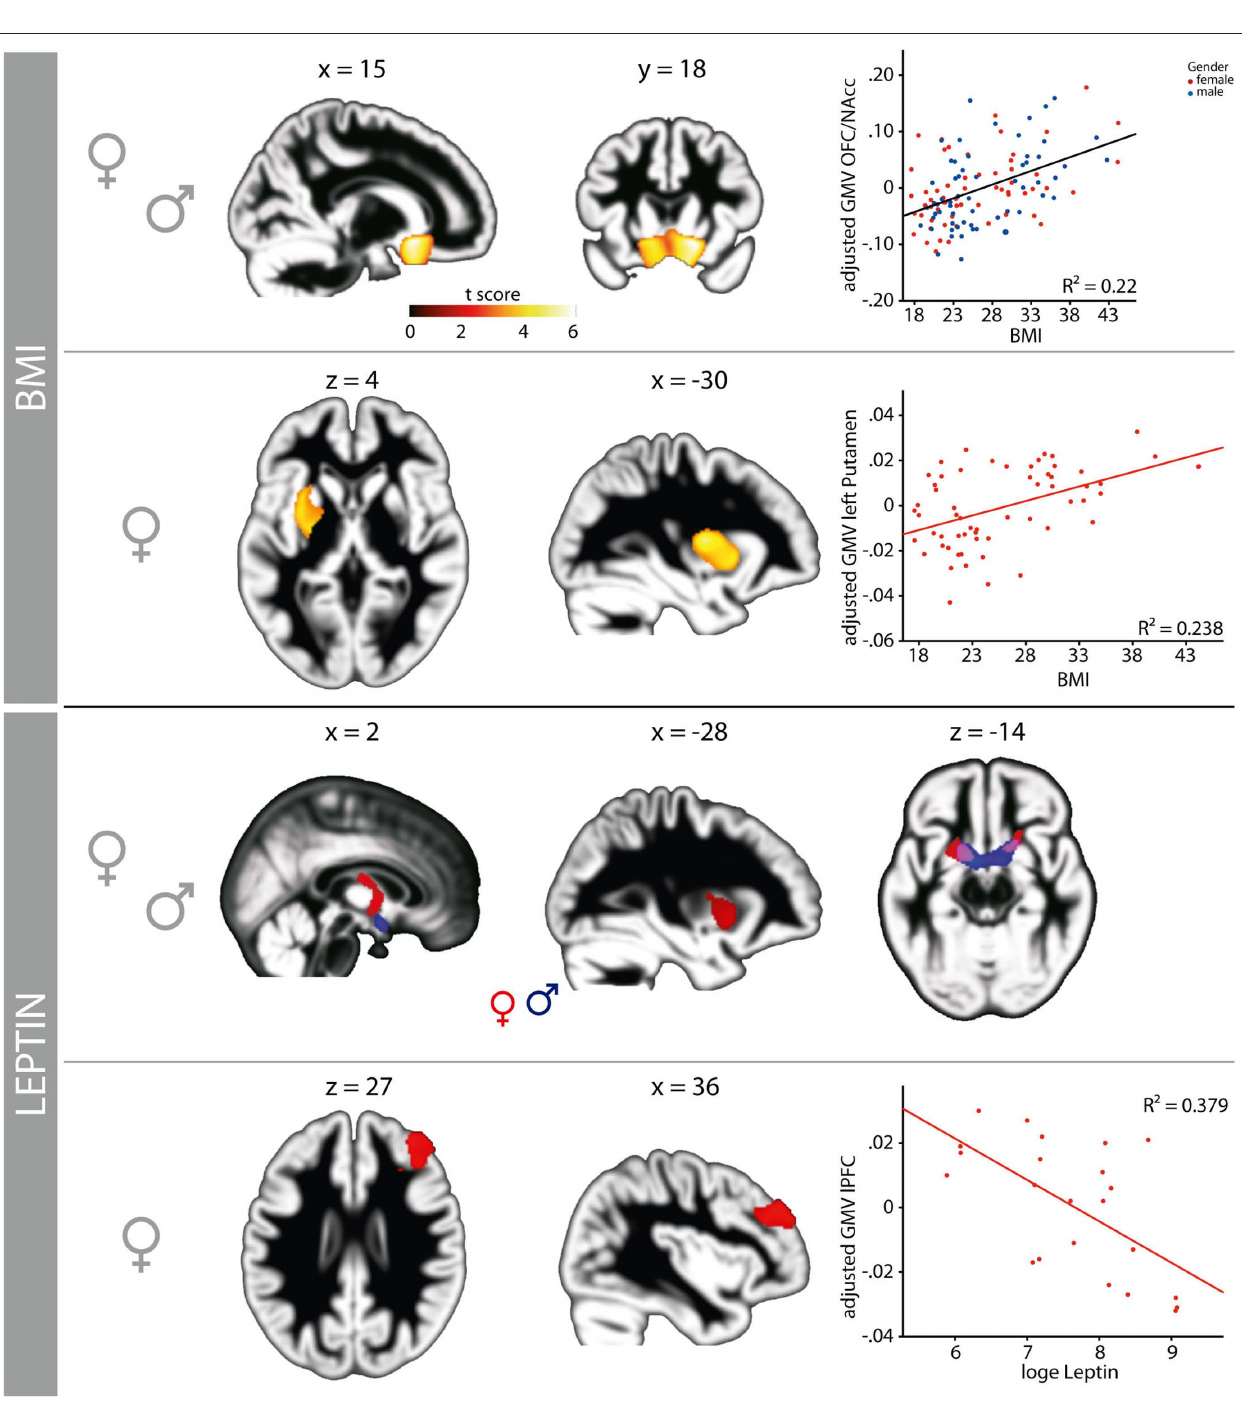
FIgure 3 | The association of obesity with profound, gender-dependent structural alterations within brain regions involved in reward processing, cognitive, and homeostatic control. The volume of posterior medial orbitofrontal cortex (OFC), nucleus accumbens (NAcc), and hypothalamus increases significantly with BMI (first panel, warm colors) in both genders. For women, an additional association between gray matter volume and BMI can be observed in the left putamen (second panel: warm colors and scatterplot). Leptin, a more direct measure of the degree of obesity, is also associated with gender-dependent changes in brain structure. The association between BMI